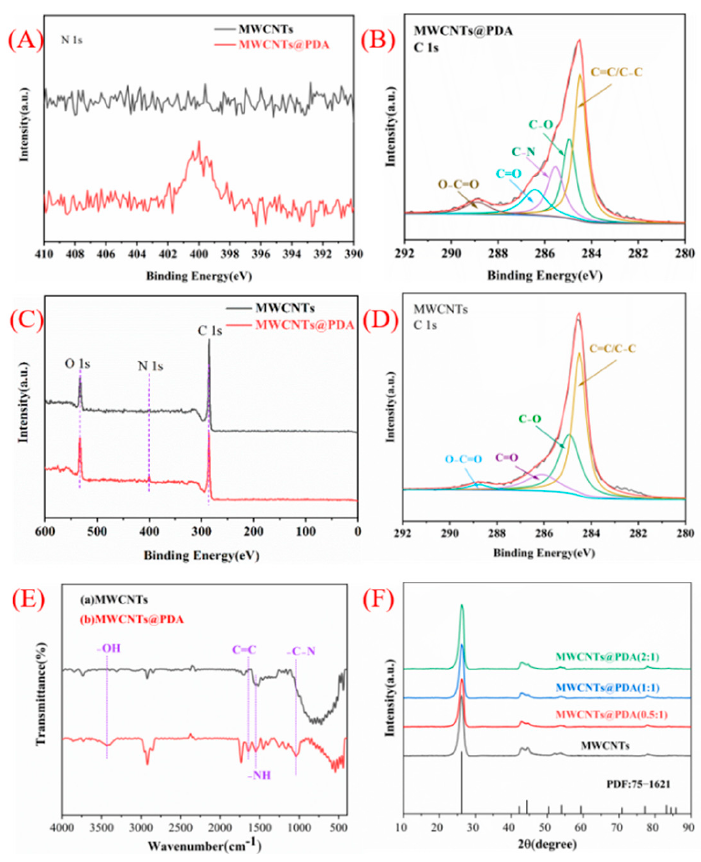
Figure 2. High − resolution XPS spectra of ( A ) N 1s peaks for MWCNTs and MWCNTs@PDA, ( B ) C 1s peaks for MWCNTs@PDA, ( C ) XPS spectra of MWCNTs and MWCNTs@PDA, ( D ) C 1s peaks for MWCNTs, ( E ) FT − IR spectra of (a) MWCNTs, (b) MWCNTs@PDA, ( F ) XRD patterns of MWCNTs and MWCNTs@PDA.